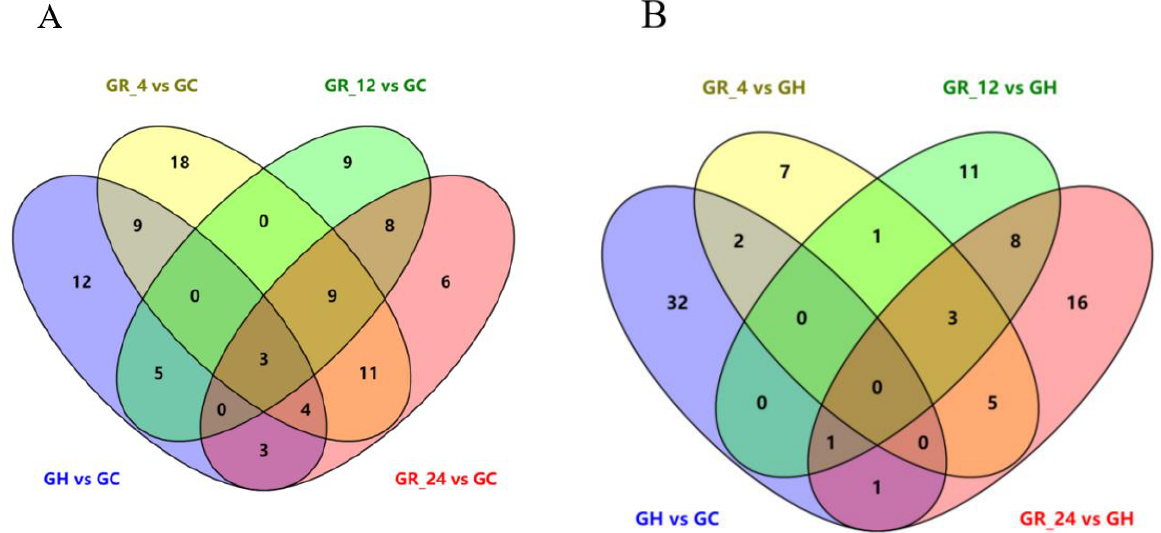
Figure 3. Venn diagrams showing differentially abundant metabolites shared and unique among the hypoxia, normoxia, and recovery groups. ( A ) Differentially abundant metabolites shared and unique across the hypoxia (GH) and recovery (GR_4, GR_12, and GR_24) groups as compared to the normoxia group (GC). Blue indicates GH vs GC group, yellow indicates GR_4 vs GC group, green indicates GR_12 vs GC group, pink indicates GR_24 vs GC group. ( B ) Differentially abundant metabolites shared and unique across the normoxia (GC) and recovery (GR_4, GR_12, and GR_24) groups as compared to the hypoxia group (GH). Blue indicates GH vs GC group, yellow indicates GR_4 vs GH group, green indicates GR_12 vs GH group, pink indicates GR_24 vs GH group. Numbers indicate the number of differentially abundant metabolites.